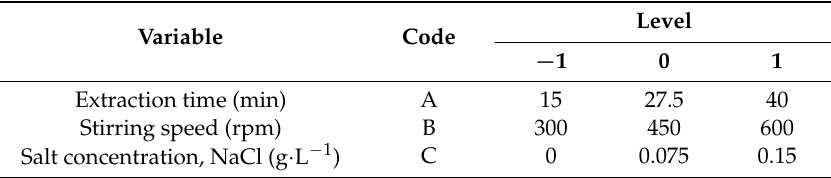
Table 2. Variables and levels used for Box-Behnken